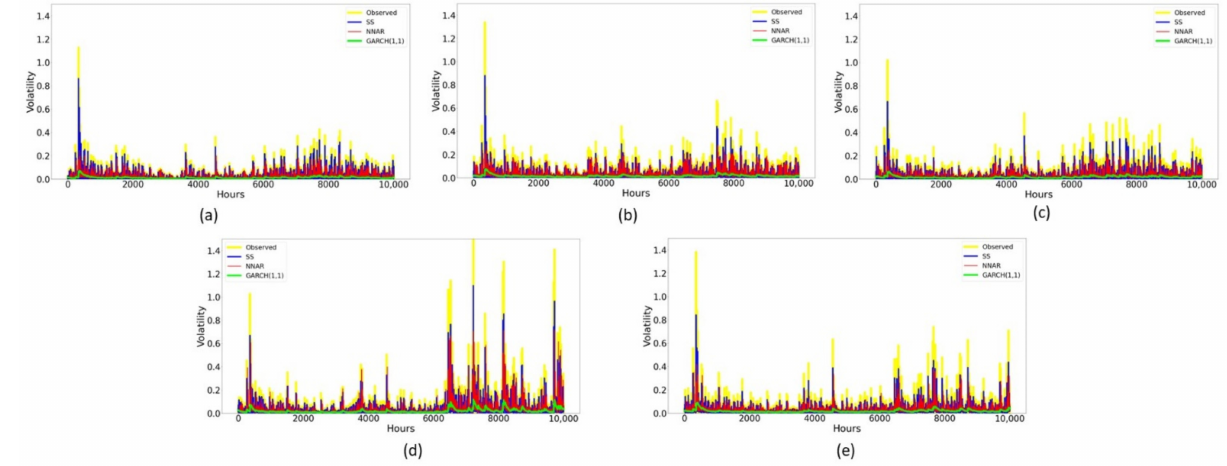
Figure 3. Volatility plots for ( a ) Bitcoin, ( b ) Ethereum, ( c ) Litecoin, ( d ) Ripple and ( e ) Bitcoin Cash. The residuals plot, autocorrelation function (ACF) plot and histogram of the estimated volatility are shown in Figures 4–8. From the histogram, only the residuals of the SS model are approximately symmetrical while the residuals of the NNAR model and the GARCH (1,1) model are both skewed to the right. In the residual versus time plot, the residuals of the SS model are also more evenly spread around the centre, 0 compared to its counterparts. The outliers in the volatility plots near time 0 are also reflected in the residual plots. In addition, the ACF plots for all models suggest that the residuals are not distinguishable from a white noise series.